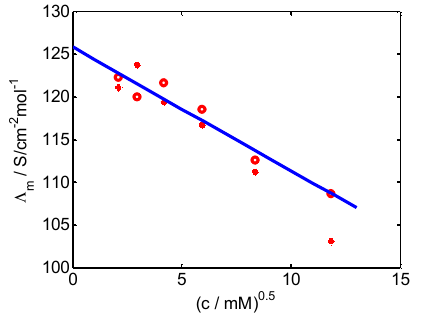
Fig.8: Test of the dilution series of PBS (phosphate buffered saline) using a WTW-conductometer with WTW-electrode (o) and from impedance measurement at the frequency with phase closest to zero (*). The theoretical Λ m (blue line) for PBS has the limit at concentration c PBS = 0 M of 126 S/cm - ²mol -1 .